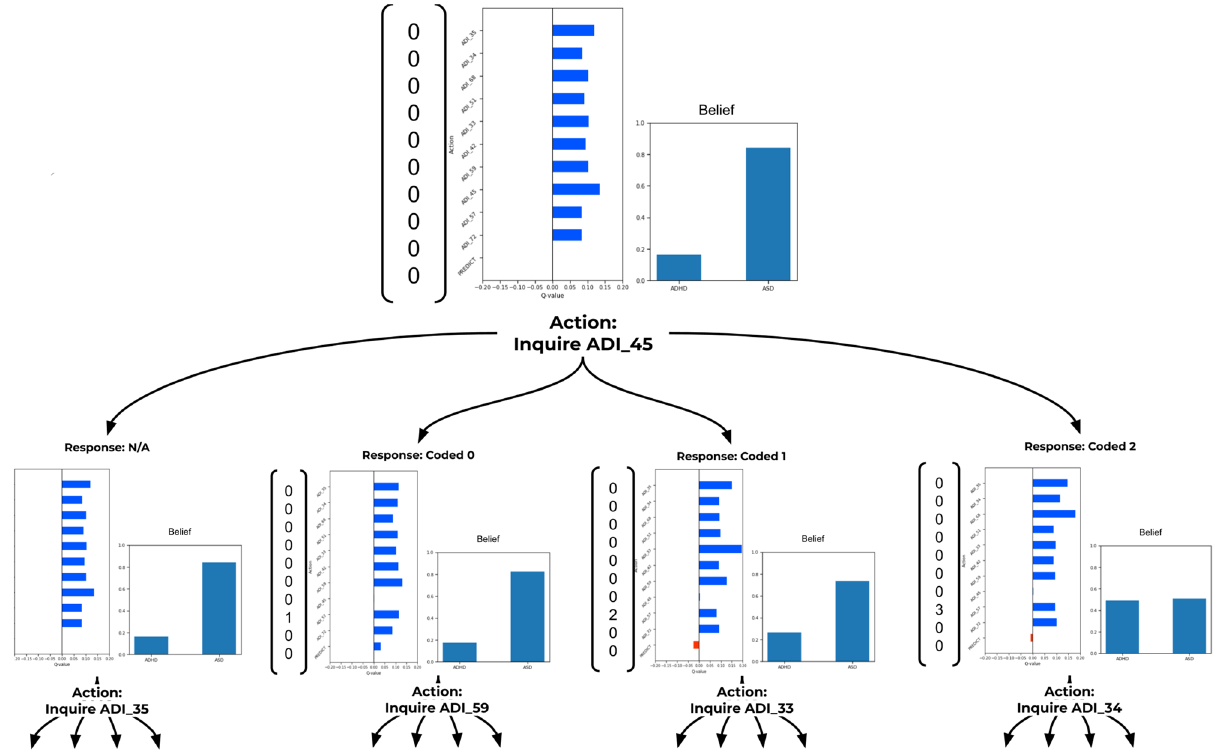
Figure 5. An example of how a policy updates with all possible responses from an inquiry. The top row captures the initial “empty” state of the policy, while the branch represent all of the possible state update that could occur depending on the observation made following the action taken. The column vector represents the state of the policy, or the items that the policy has information about so far. The horizontal bar chart captures the relative Q-value of each action (actions are equivalent to querying an item or making a prediction). As ADI_45 has the highest Q-value, it is the first item that is queried by the policy. The arrows capture possible responses,